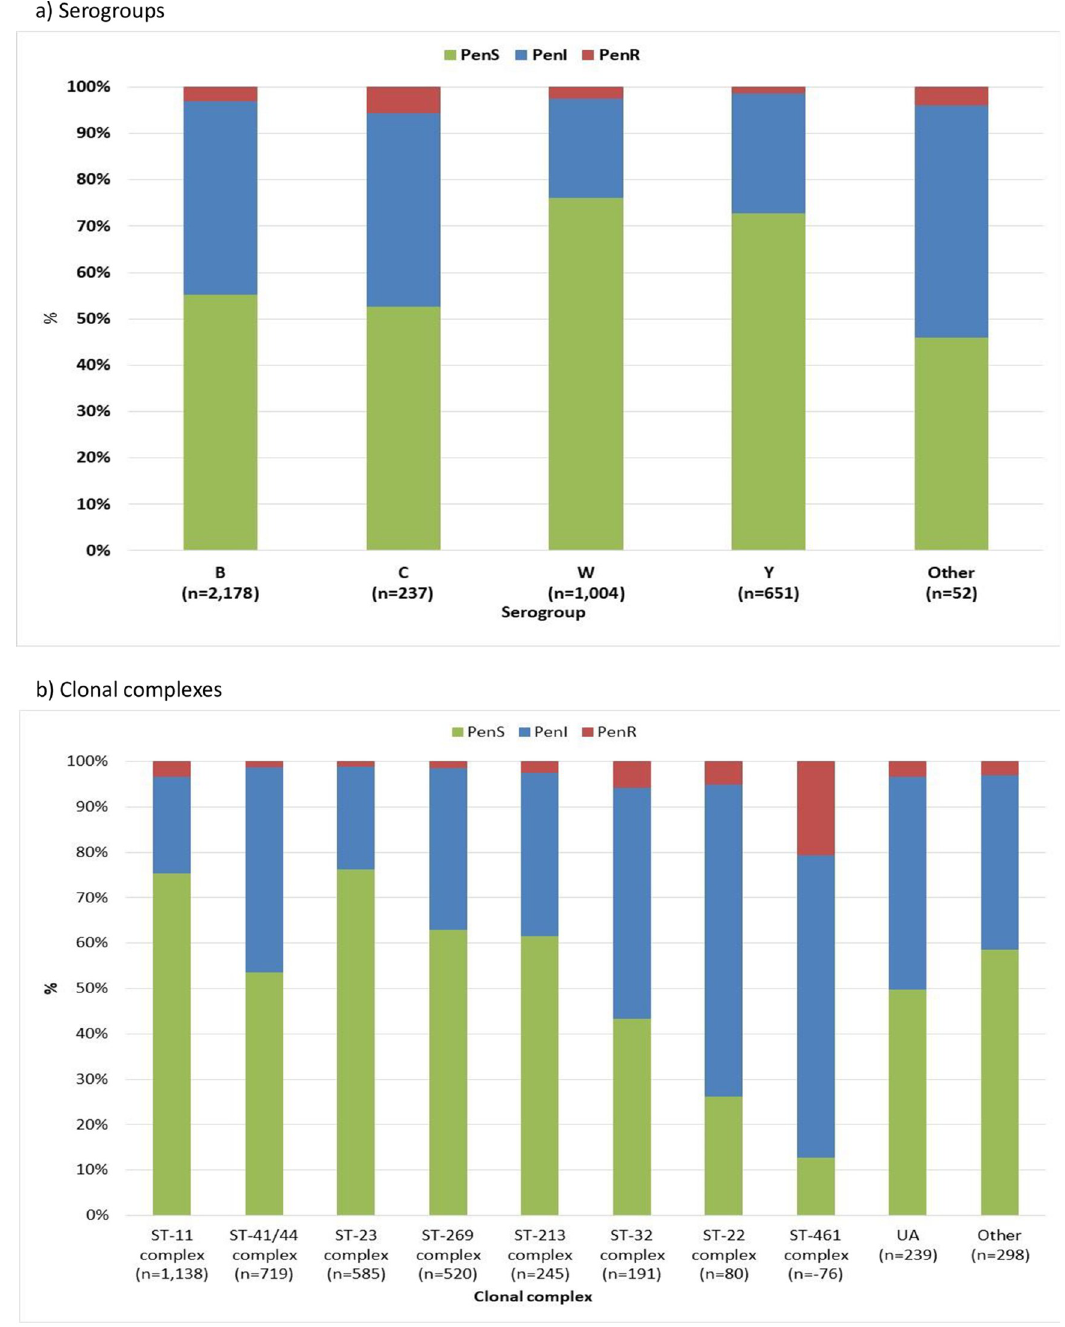
Fig 1. Penicillin susceptibility among serogroups and clonal complexes of IMD isolates in England, Wales and Northern Ireland, 2010/11 to 2018/19.